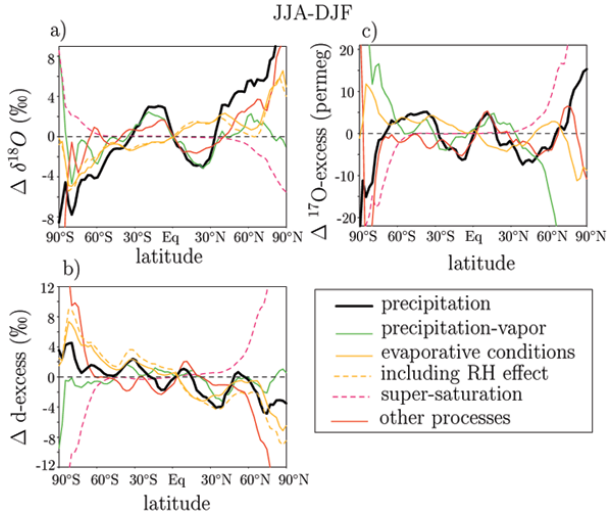
Fig. 9. Same as figure 8, but for JJA-DJF differences. When the black line is positive, the δ 18 O , d-excess or 17 O -excess values are higher in JJA than in DJF (i.e. higher in summer in the northern Hemisphere, higher in winter in the Southern Hemisphere, higher during the wet season in the northern tropics, higher during the dry season in the southern tropics). When the colored curves are of the same sign as the black curves, then the corresponding process con- tributes positively to the total seasonal